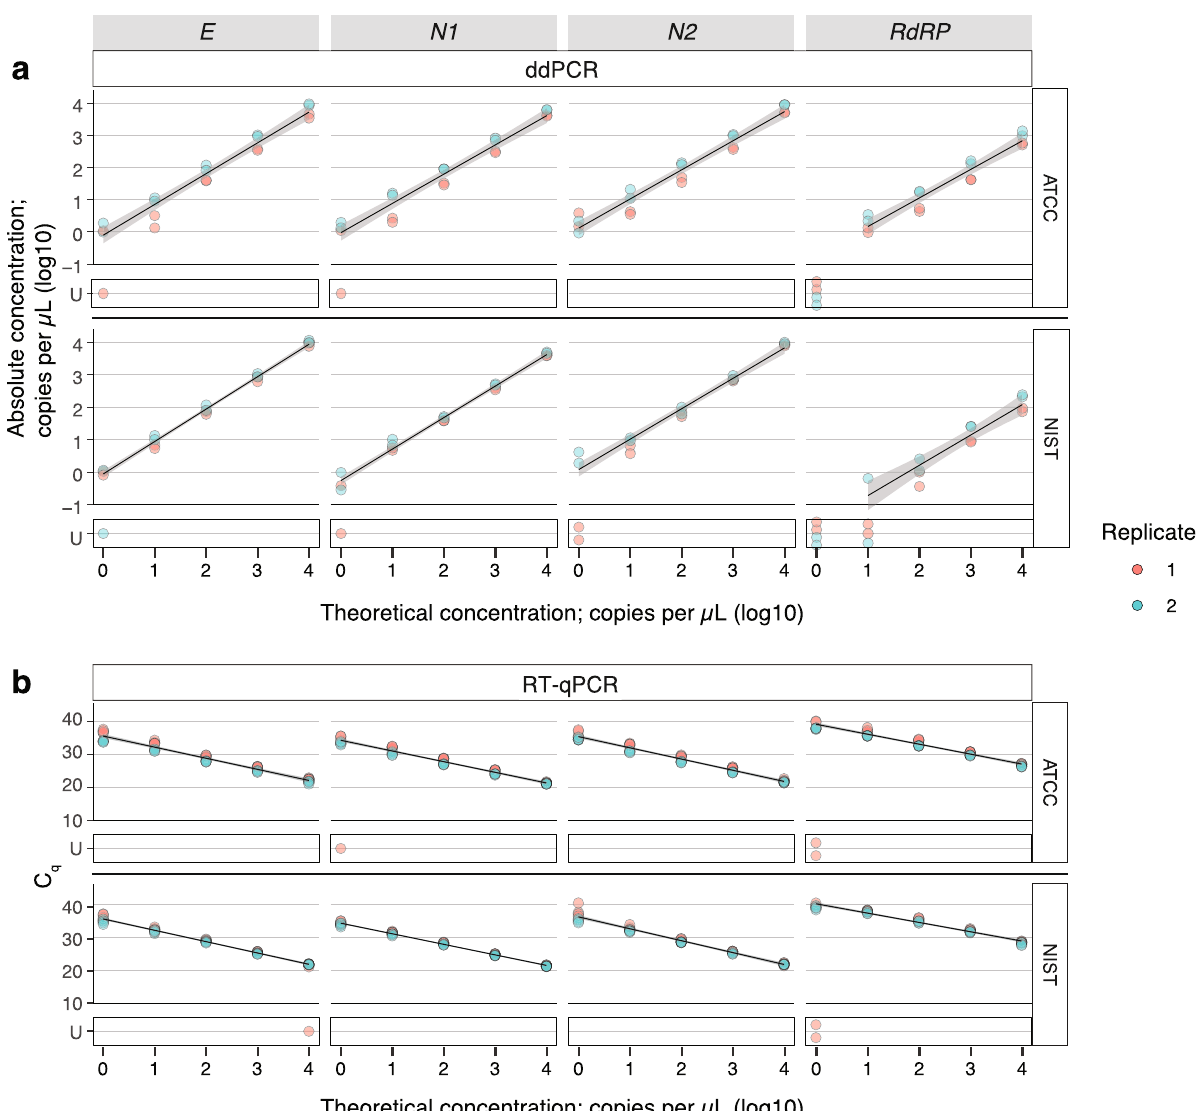
Fig. 1 Robustness of synthetic SARS-CoV-2 RNA standards from ATCC and NIST. ddPCR and RT-qPCR assays targeting four SARS-CoV-2 RNA targets (E, N1, N2, and RdRP) across a fi ve-point tenfold concentration range of RNA standards from either ATCC or NIST (indicated on the tab to the right). a Theoretical concentrations of RNA are plotted on the x -axis and absolute copy number derived from ddPCR is plotted on the y -axis. All assays were performed in duplicate. b Theoretical concentrations of RNA are plotted on the x -axis and C q derived from RT-qPCR is plotted on the y -axis. All assays were performed in quadruplicate. Replicates in red and blue refer to two independent experiments performed by two users using separate aliquots of samples. Linear regression is plotted in black and 95% con fi dence interval is shaded in gray. Samples that did not amplify are delineated as U for undetermined and are not included in the linear regression analysis. Associated statistics are summarized in Supplementary Data 1. Source data are provided as a Source data fi